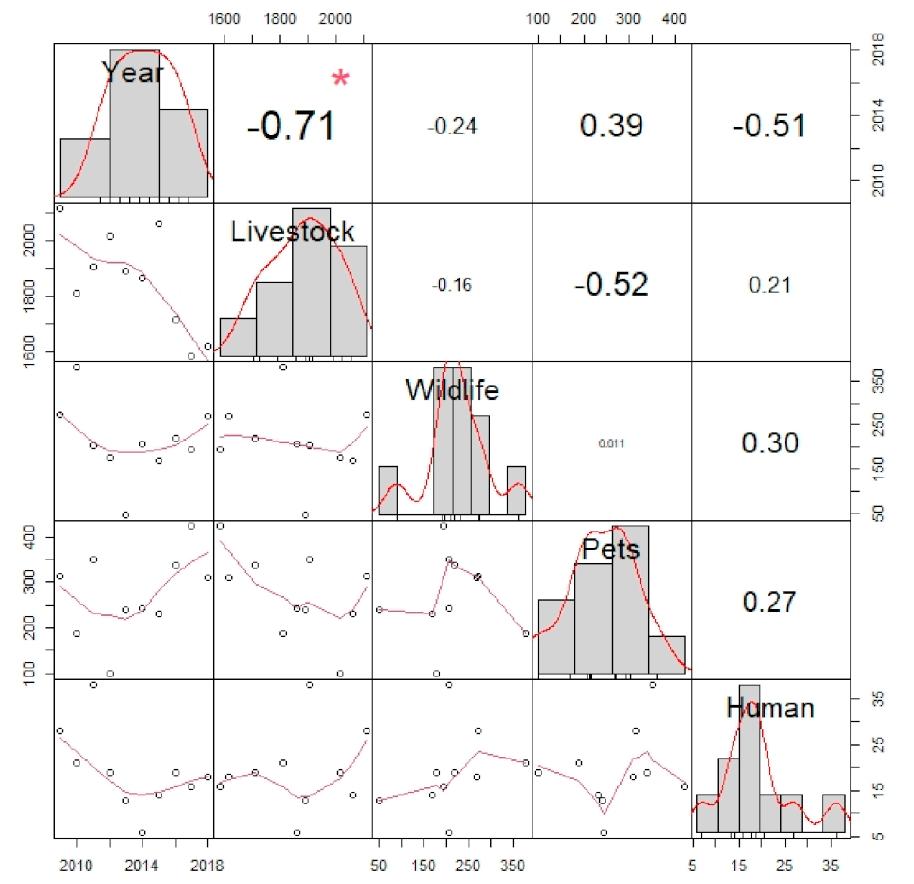
Figure 2. Graph showing the correlation between the number of cases in the different groups of species and over time. The numbers on the right side of the graph represent the correlation coefficient. An asterisk close to the numbers indicates a significant correlation ( p < 0.05). Data distribution for each category is represented by mean of bar charts. The relation between a pair of variables is represented on the left side of the